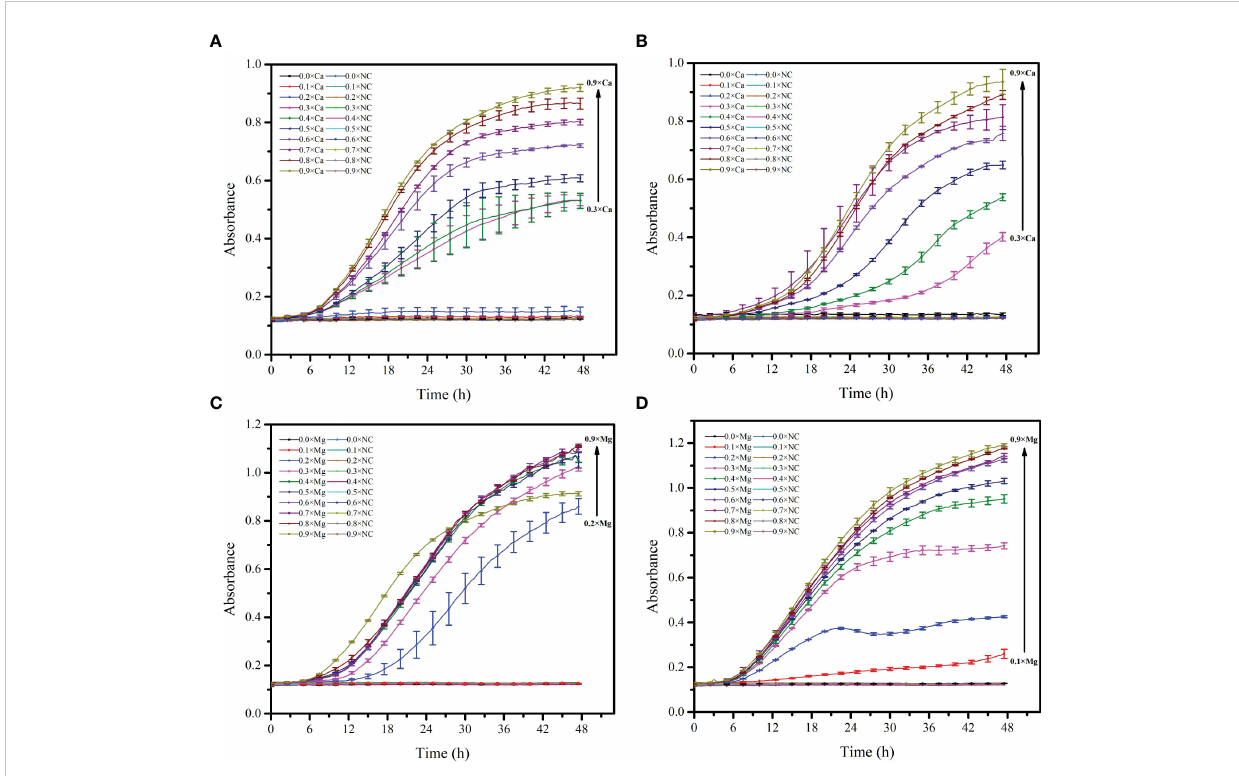
FIGURE 7 Growth curve of Alteromonas with different concentrations of Ca 2+ and Mg 2+ . (A, C) , A. alteriprofundi HHU 13199 T ; (B, D) , A. alterisediminis N102 T